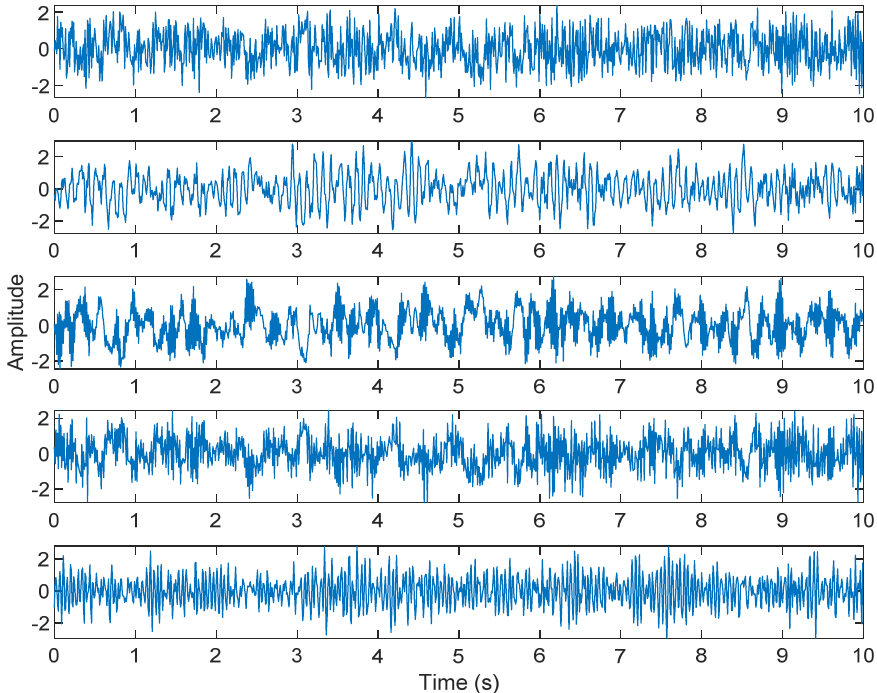
Figure 10. Analysis of data separated by VMD-ICA.